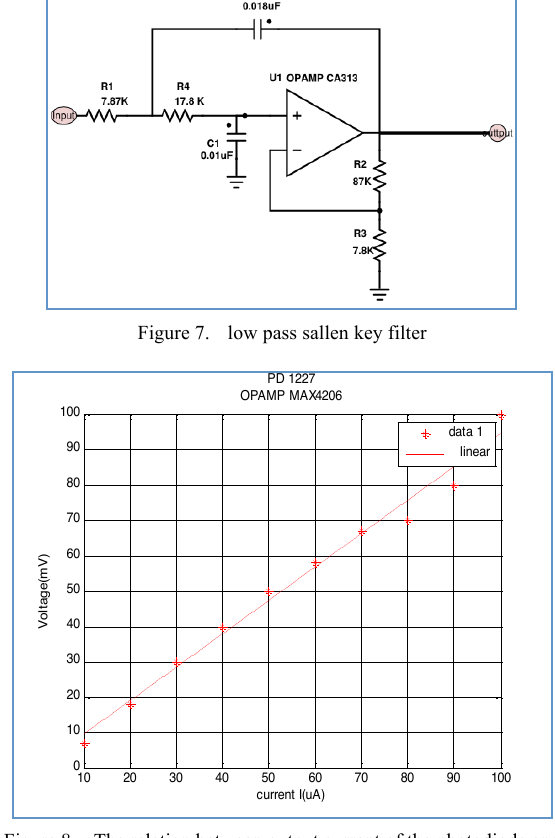
Figure 8. The relation between output current of the photodiode and the output voltage for the transimpedance amplifier